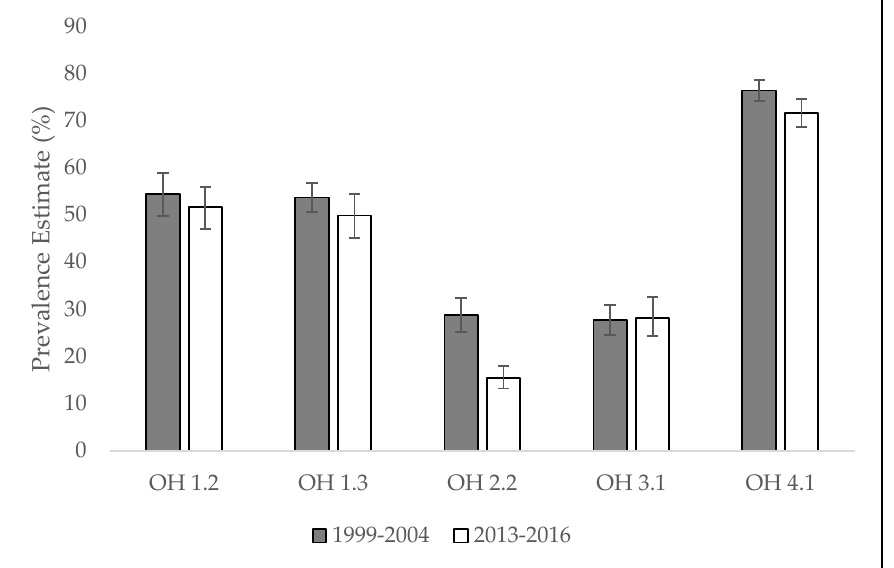
Figure 1. Proportion estimates for selected indicators. Error bars represent 95% CI. Healthy People